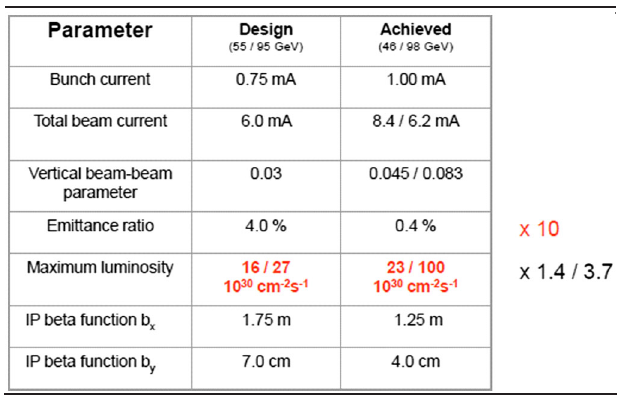
TABLE III. LEP Performance parameters.